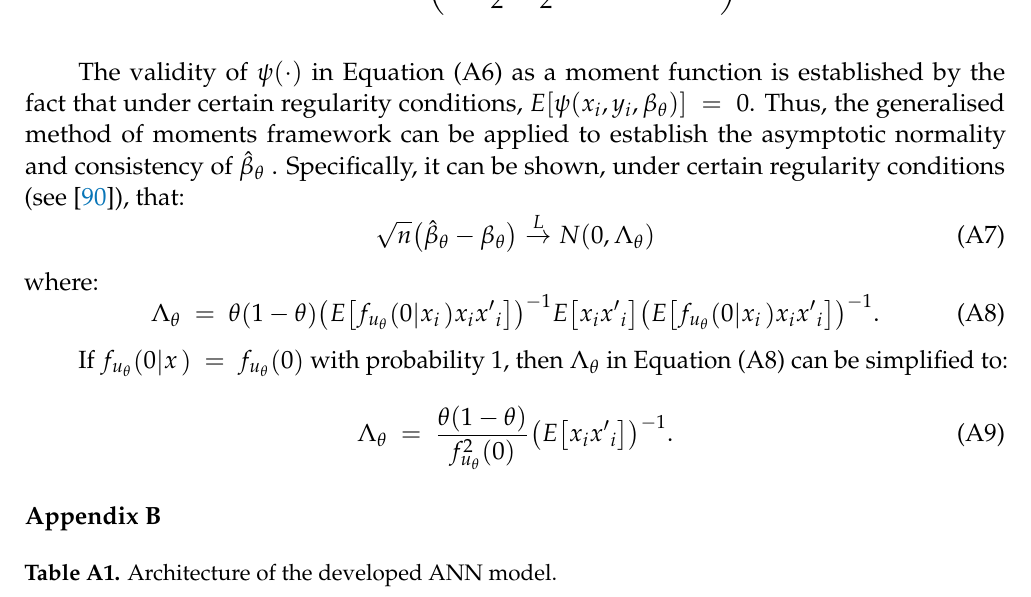
Table A1. Architecture of the developed ANN model.